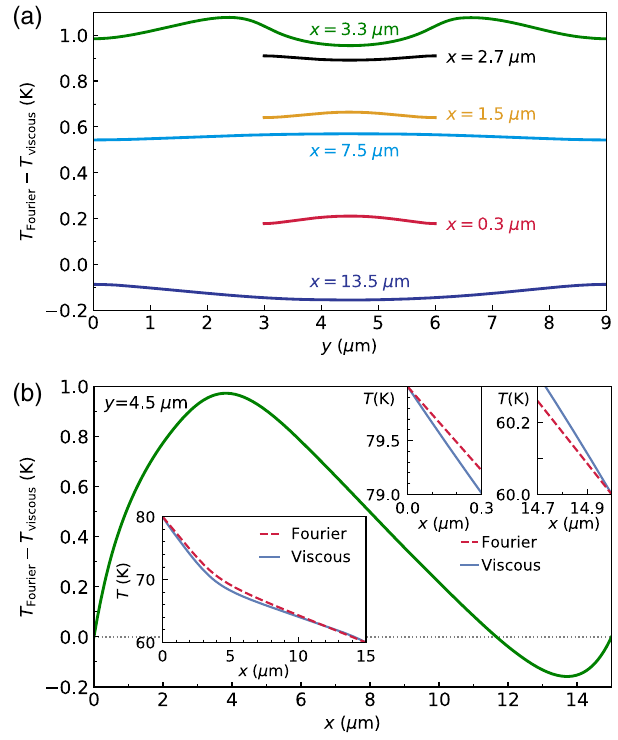
FIG. 4. Difference between the temperature profiles predicted by Fourier ’ s law and by the viscous heat equations, plotted in (a) along y for various values of x and in (b) along x for y ¼ 4 . 5 μ m. The insets of (b) show the temperature profile along x for y ¼ 4 . 5 μ m; the result of the viscous heat equations (10) and (11) is the solid blue line, Fourier ’ s law prediction is the dashed red